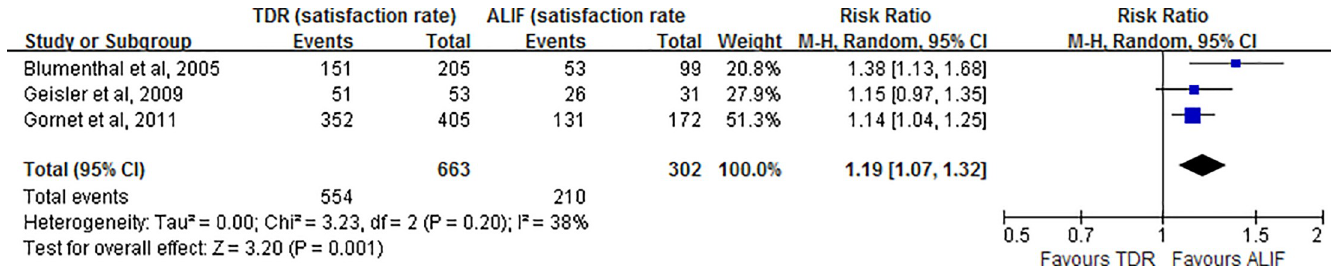
Fig 7. Forest plot for postoperative patient satisfaction. df = degrees of freedom, and M-H = Mantel-Haenszel.